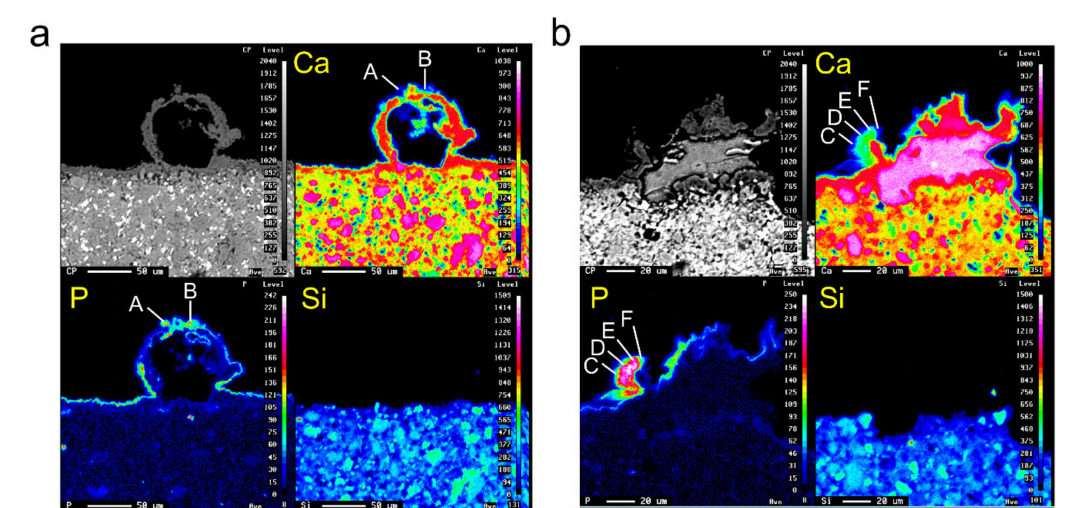
Figure 10. Electron-probe microanalysis (EPMA)-based elemental-mapping images of Ca, P and Si in representative mineralized precipitates. ( a ) Spherical and ( b ) triangular-pyramid-shaped precipitates (scale bar ( a ) 50 and ( b ) 20 µ m). Ca / P molar ratios of each point, calculated on the basis of fluorite, were 0.82 for A, 1.15 for B, 1.95 for C, 1.63 for D, 1.69 for E and 2.01 for